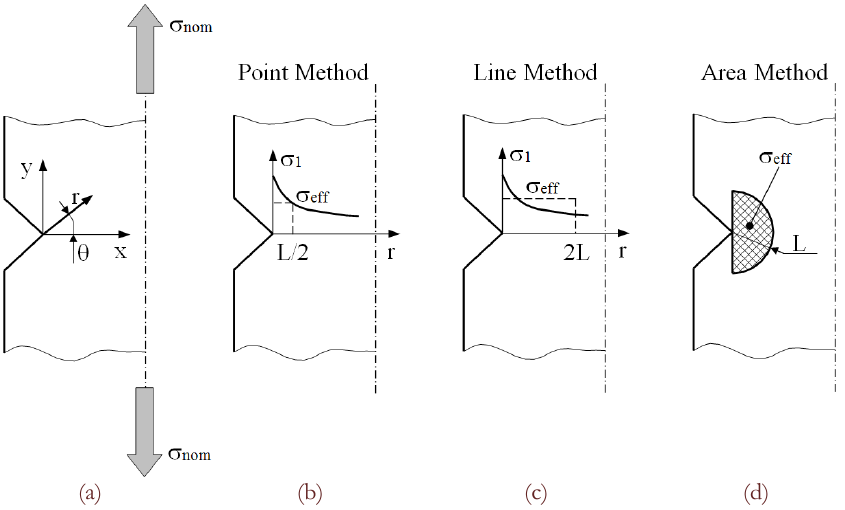
Figure 1: Definition of the local systems of coordinates (a) and effective stress,  eff , calculated according to the Point Method (b), Line Method (c), and Area Method